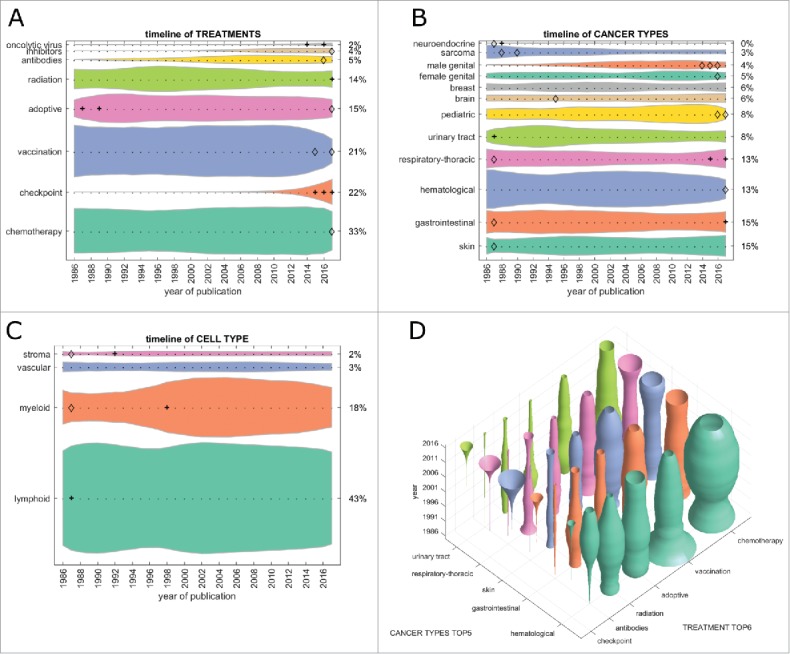
Trends in PubMed publications from 1986 to 2017 by topic. This Fig. summarizes all PubMed listed cancer immunotherapy articles grouped by category. (A) Among all cancer immunotherapy articles published in 2017, 33% referred to one or more specific chemotherapy drugs (bottom shape). This proportion was roughly constant over three decades. Contrariwise, checkpoint inhibition was almost absent before 2010, showing an accelerating growth afterwards. (B) Hematological neoplasms were the most commonly investigated immunotherapy target until 2014, when they were overtaken by gastrointestinal and skin neoplasms. (C) Among all major cell types in the tumor microenvironment, myeloid cells were rapidly gaining interest around the year 2000. Afterwards, no significant change whatsoever was observed. (D) Bivariate analysis of treatment types versus cancer types in PubMed cancer immunotherapy publications. Checkpoint inhibition shows a markedly increasing trend (“trumpet”) in skin, respiratory, but also urinary tract and gastrointestinal cancer. (A-C) + significant rise of growth rate within one year (anomaly >95%), ◊ significant decrease of one-year growth rate (anomaly < 5%).